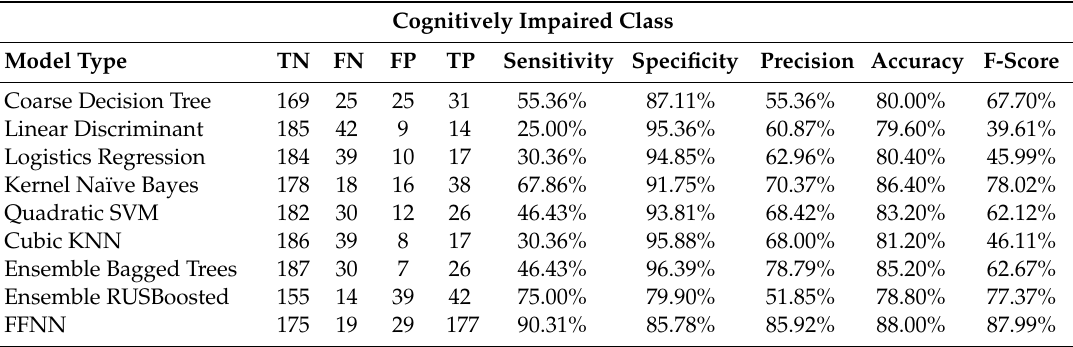
Table 2. Train the model with Imbalanced Data (Except FFNN).